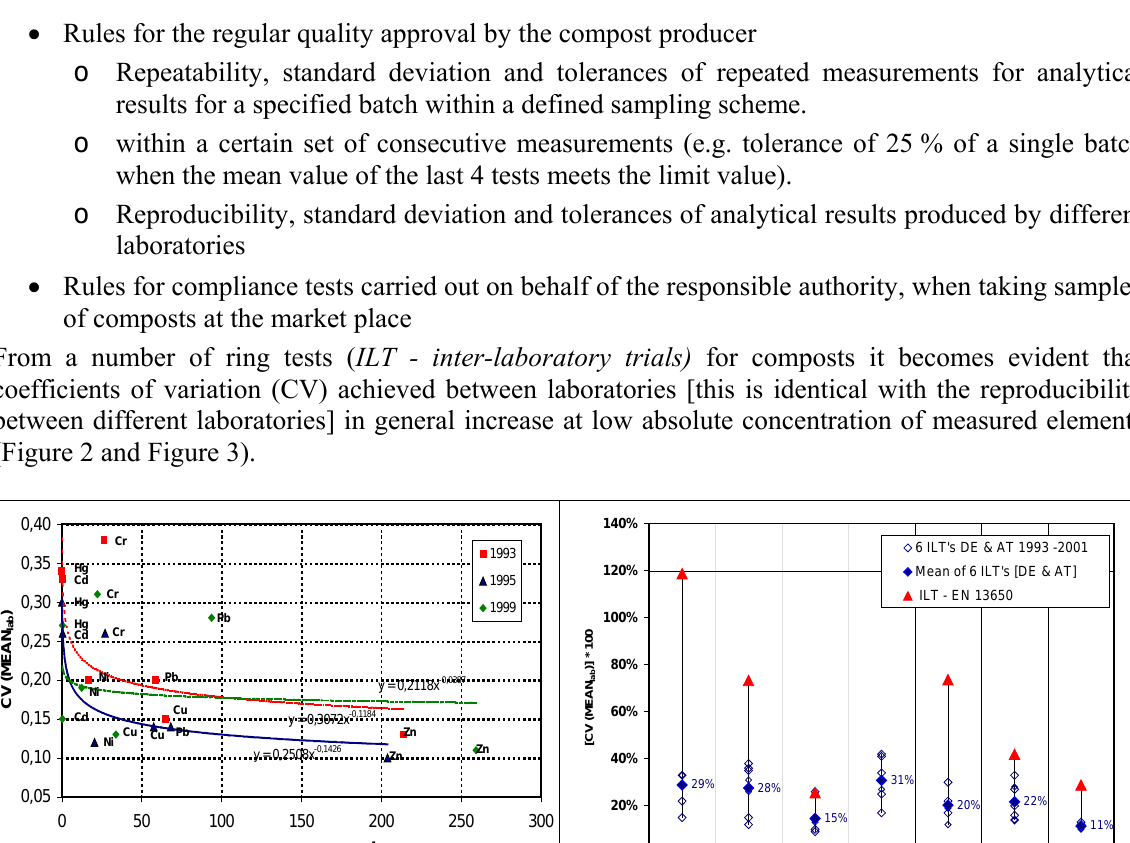
Figure 3: Coefficient of Variation of laboratory mean values [CV(MEANlab)] between participating laboratories of 6 German and Austrian inter- laboratory trials 1993 - 2001 and in the CEN TC 223 ILT for the European standard EN 13650: Soil improvers and growing media. Extraction of aqua regia soluble